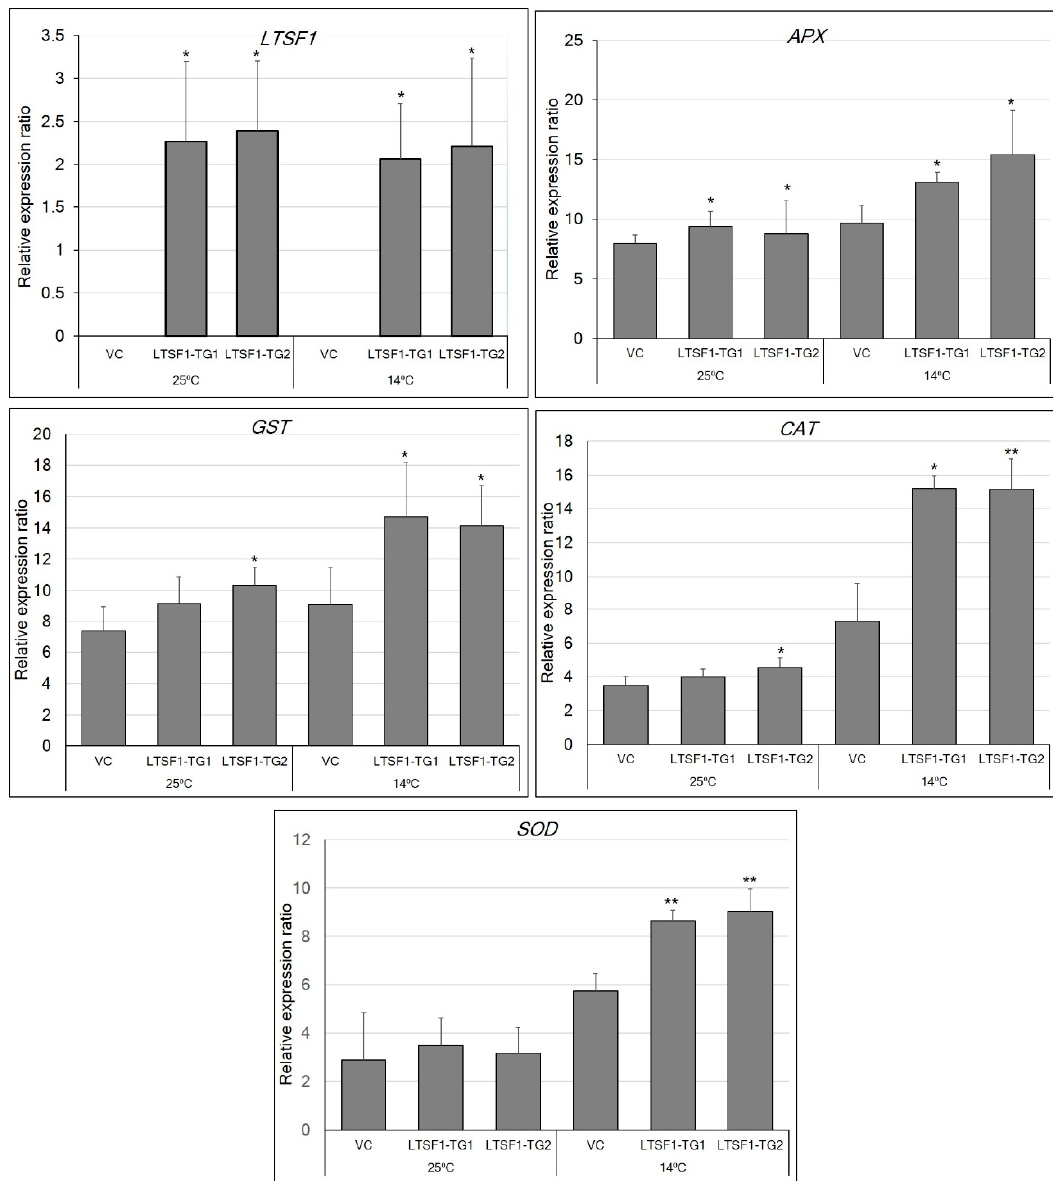
Figure 5. Relative expressions of levels of LTSF1 and antioxidant-enzyme related genes (ascorbate peroxidase (APX), catalase (CAT), glutathione S-transferases (GST), and superoxide dismutase (SOD)) in transgenic N. benthamiana plants. The error bars indicate the mean ± SD of six biological replicates. * p < 0.05 and ** p < 0.01 vs. the vector control (VC).